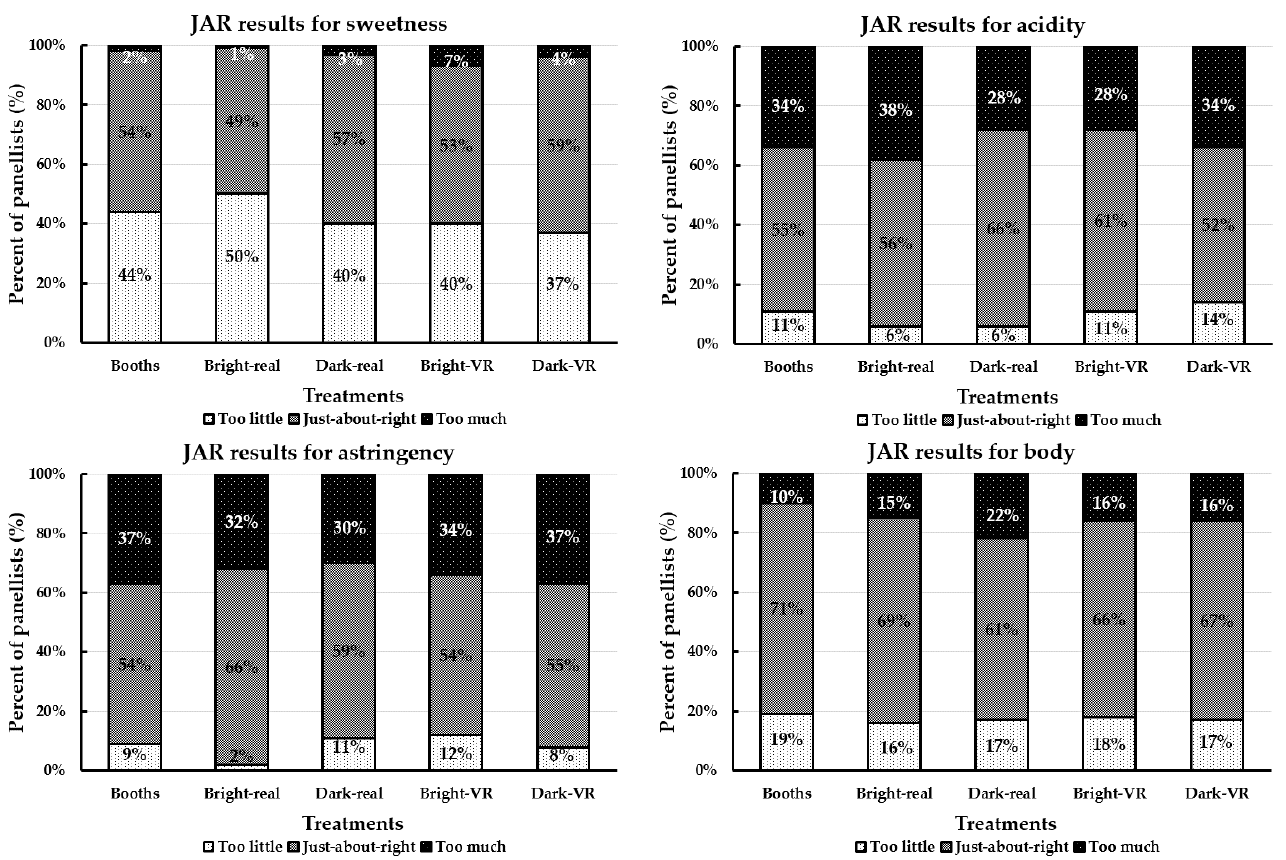
Figure 2. Selection frequencies (%) of just ‐ about ‐ right (JAR) results for the sweetness, acidity, astringency, and body of the wine sample in different environments 1 . 1 Booths = traditional sensory booths, Bright ‐ real = bright restaurant real environment, Dark ‐ real = dark restaurant real environment, Bright ‐ VR = bright restaurant virtual reality (VR) environment, and Dark ‐ VR = dark restaurant VR environment.